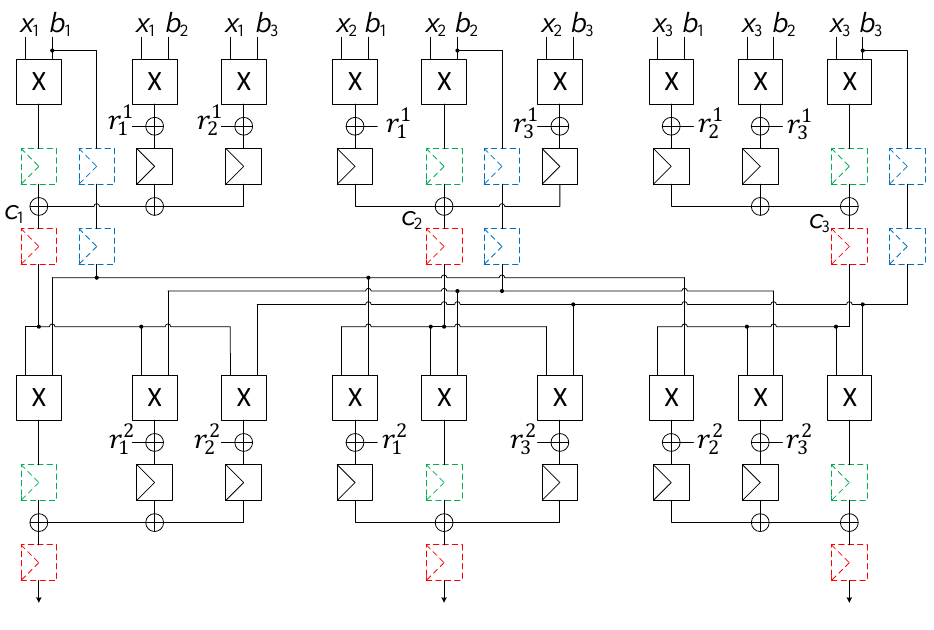
Figure 13: Composition of two DOM- indep multiplications (d = 2) with several kinds of (mandatory and optional) pipelining and synchronization register